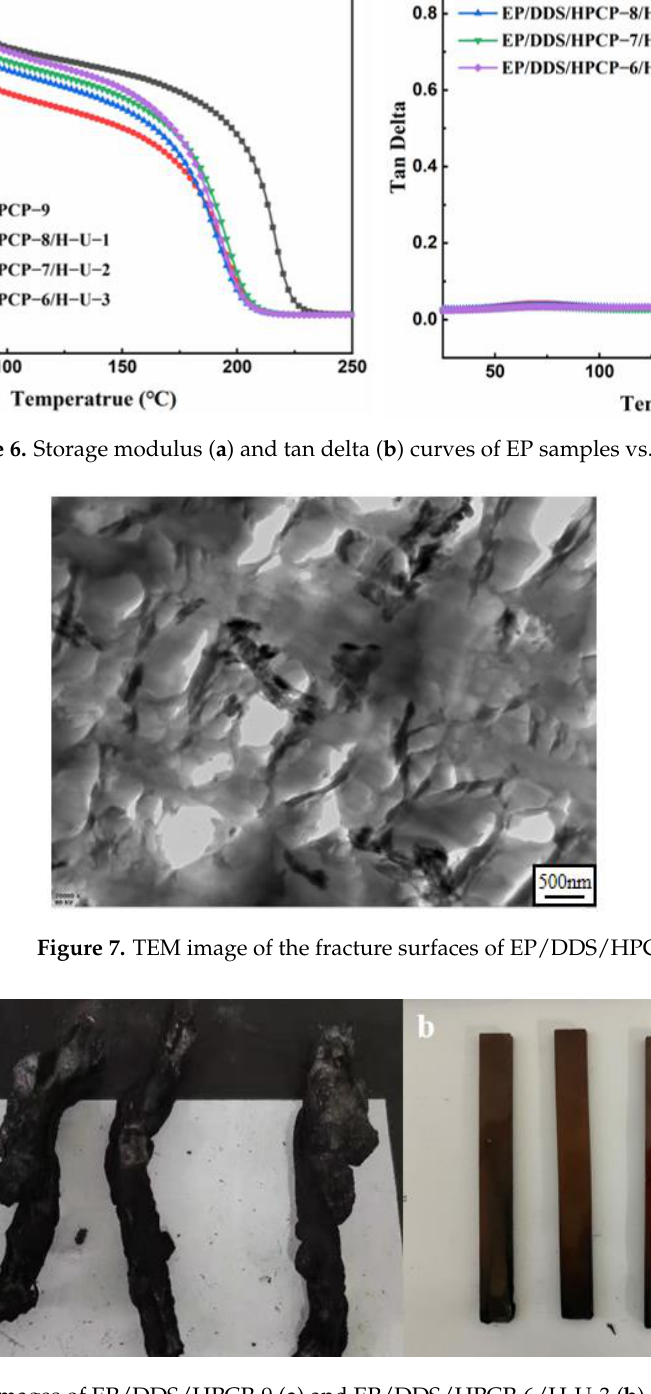
Figure 8. Digital images of EP/DDS/HPCP − 9 ( a ) and EP/DDS/HPCP − 6/H − U − 3 ( b ) samples after UL − 94 tests.